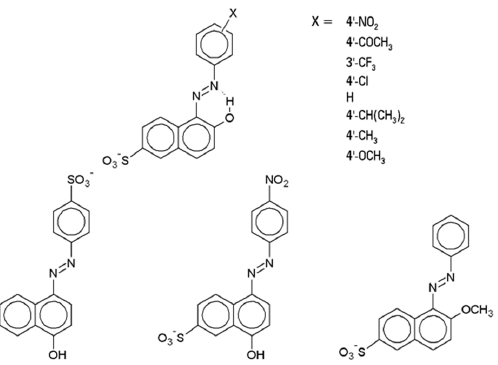
Figure 4. Substituted phenylazo derivatives of substituted 1- or 2-naphthols studied as substrates